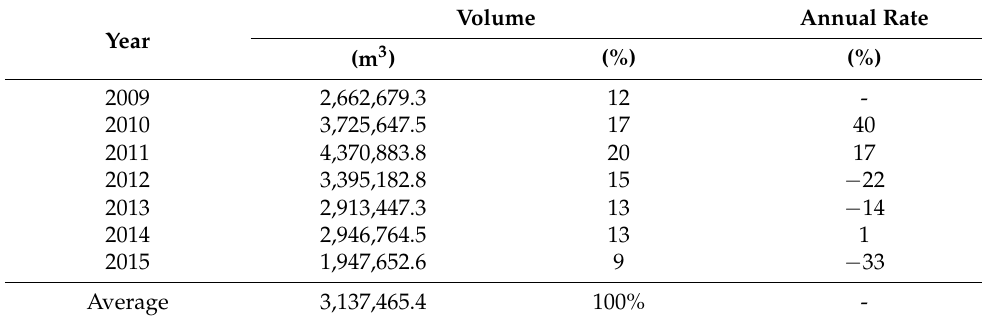
Table 1. Volume and annual rates of increase and decrease in wood marketed in the state of Par á